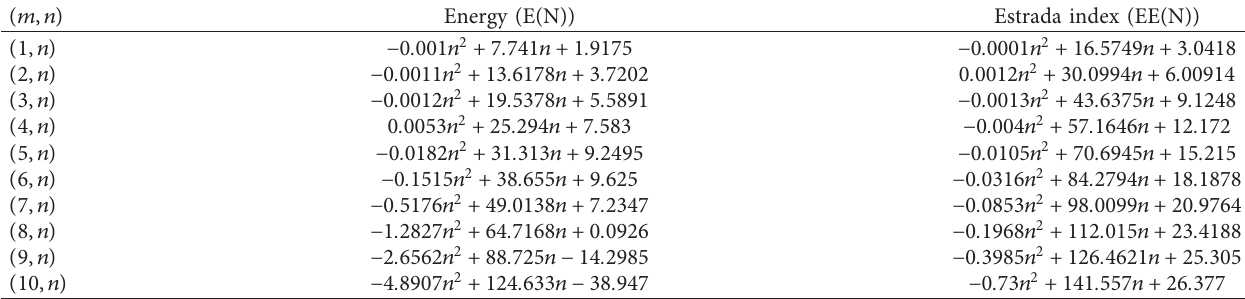
C nanosheet. 4 8